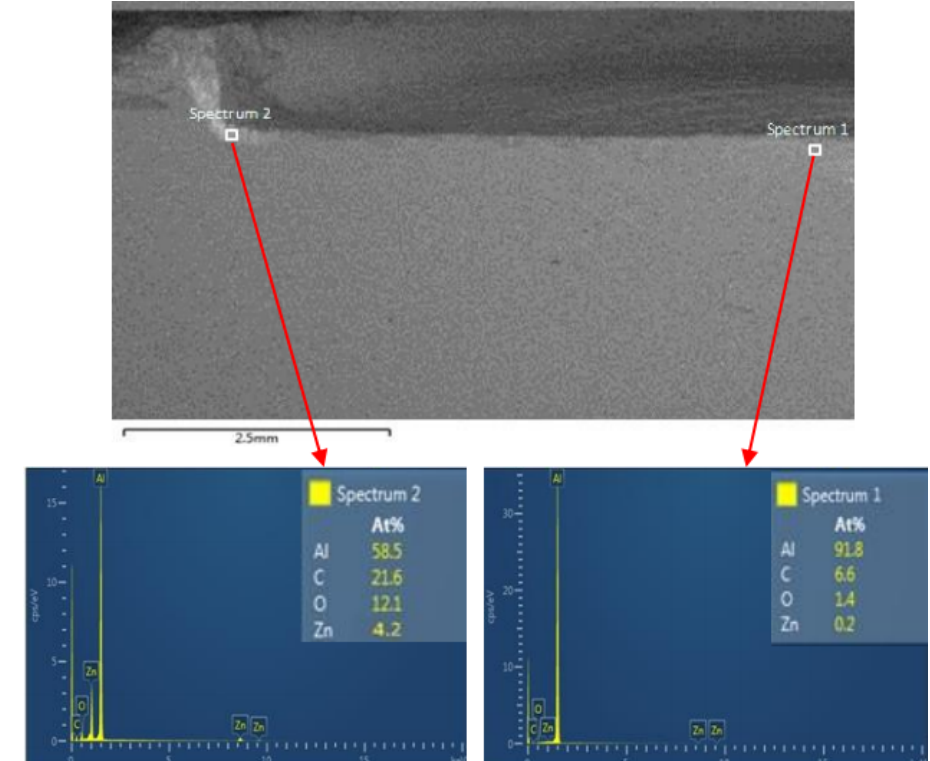
Figure 6: Atomic percentage of Zn at the edge and centre of the friction stir processing zone